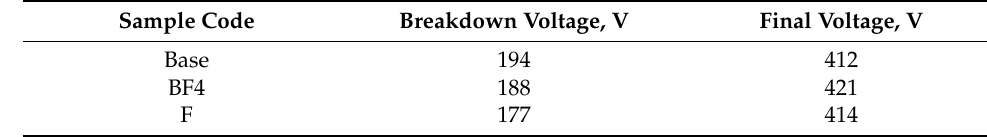
Figure 1. Voltage ‐ time curves during the PEO process in the different electrolytes. Figure 1. Voltage-time curves during the PEO process in the different electrolytes. Table 4. The breakdown voltage values and final voltage in the different